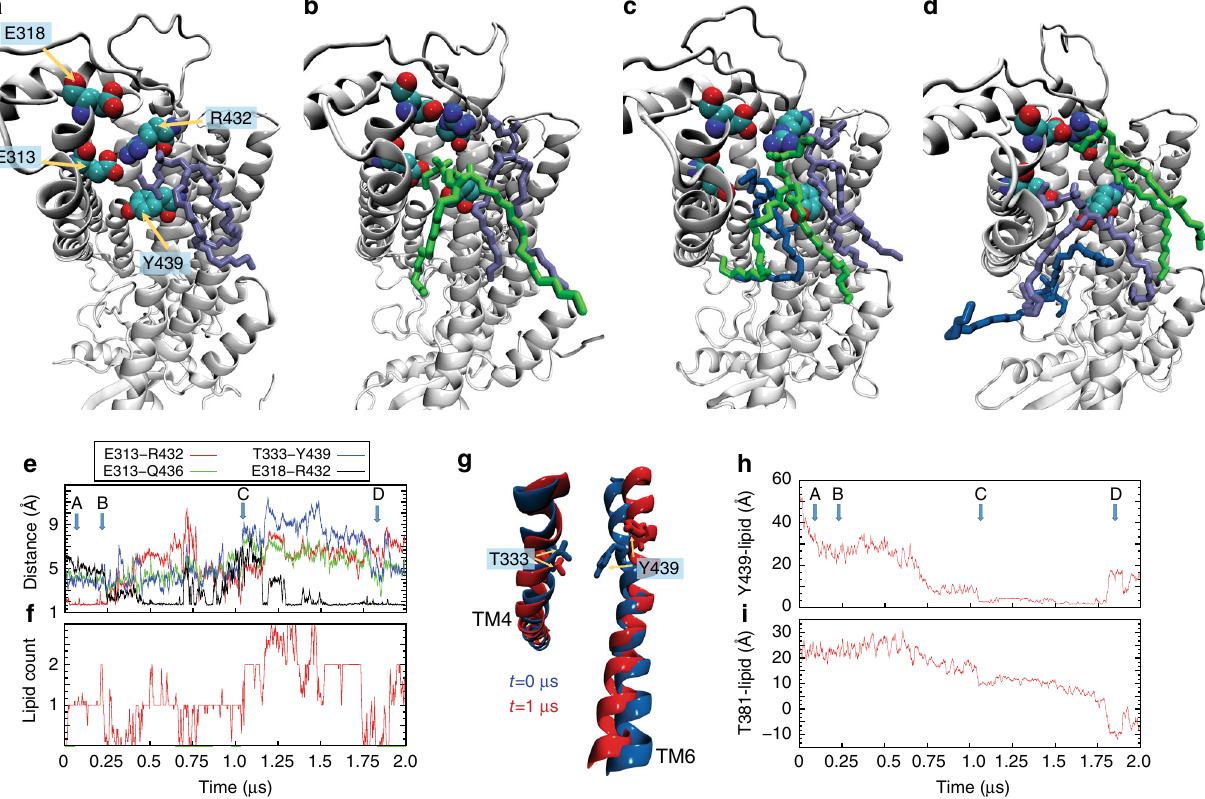
Fig. 6 Rearrangements of the groove underlying phospholipid fl ipping. a – d Positioning of residues E313, E318, R432, and Y439 and of lipids neighboring the E313/R432 pair at various stages of the simulations. a The E313-R432 gate is closed; b R432 switches interaction partner from E313 to E318; c R432 breaks away from both E313 and E318 allowing lipid penetration deep into the groove (blue lipid); d the translocated lipid (in blue) completes the fl ip as its headgroup is on the level of the lipid headgroups in the intracellular lea fl et. The time points at which these snapshots were taken from the A385W trajectory are indicated by arrows in e , h . e Time evolution of the distances between E313-R432 (red), E313-Q436 (green), T333-Y439 (blue), and E318- R432 (black). f Time evolution of the number of lipid headgroups within 5 Å of residues E313 and R432. g Snapshots at t = 0 µ s (blue) and t = 1 µ s (red) time-points along the A385W simulation showing conformational switch in the T333 and Y439 residues (in licorice and labeled) and corresponding rearrangement of the TM4 and TM6 helices (in cartoon). Note the outward movement of the Y439 side-chain and concomitant repositioning of the extracellular end of the TM6 that opens a pathway for lipid translocation. h Time evolution of the distance between the headgroup of the fl ipped lipid and the Y439 side chain ( h ) and of the z -axis position distance between the penetrating lipids and the C α atom of the T381 residue ( i